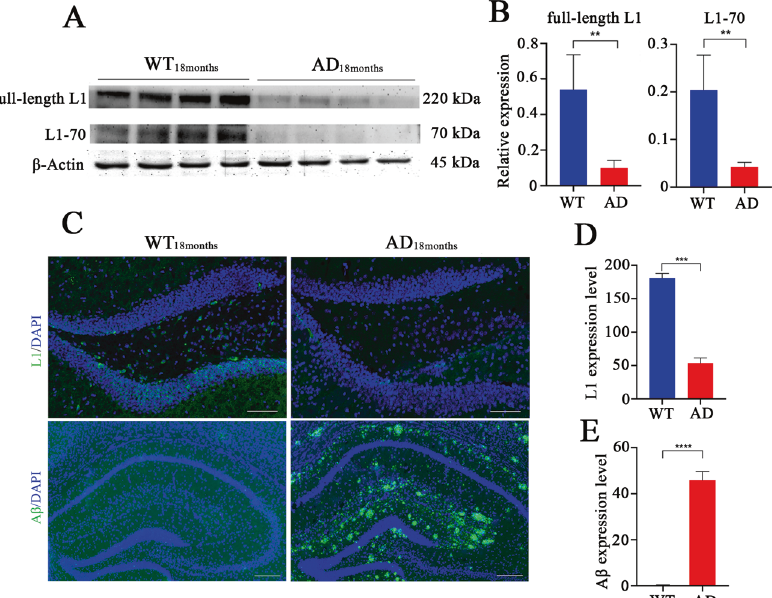
Fig. 1 Expression of full-length L1, L1-70, and A β in the hippocampus of 18-month-old wild-type and APPswe mice. A Western blot analysis of hippocampal tissue homogenates of 18-month-old wild-type mice and APPswe mice. B Relative full-length L1 and L1-70 levels were calculated and normalized to β -Actin. Data were shown as means ± SD, ** p < 0.01, Student ’ s t -test, n = 4 mice per group. C Representative immuno fl uorescence images of hippocampal tissue sections from 18-month-old wild-type and 18-month-old APPswe mice. Antibodies against L1 cytoplasmic domain and A β were used for immunostaining. Expression of L1 and A β in 18-month-old wild-type mice and 18-month-old APPswe mice are shown. D , E Full-length L1 and A β levels were calculated using ImageJ. Data were shown as means ± SD, *** p < 0.001, **** p < 0.0001, Student ’ s t -test, n = 4 mice per group. Scale bars: 100